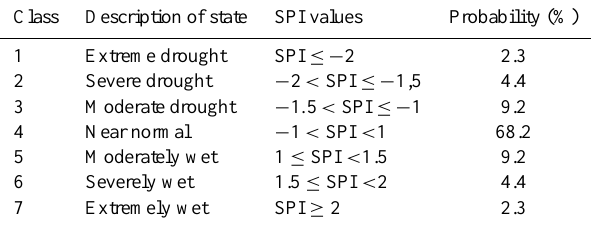
Table 1. Classification scale for the SPI values and corresponding event probabilities (McKee et al., 1993; Lloyd-Hughes and Saun- ders, 2002).